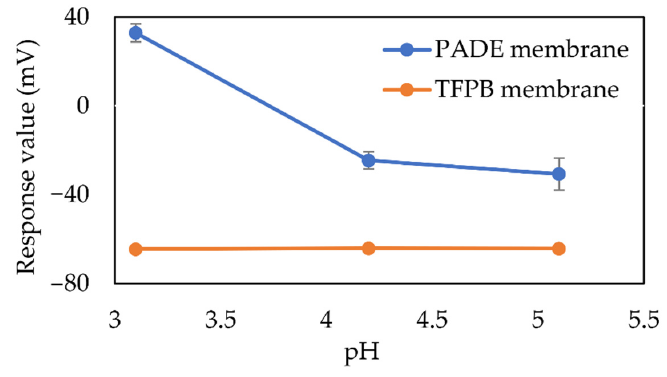
Figure 7. Sensor responses ( V s − V r ) to 100 mM NaCl sample at different pH.